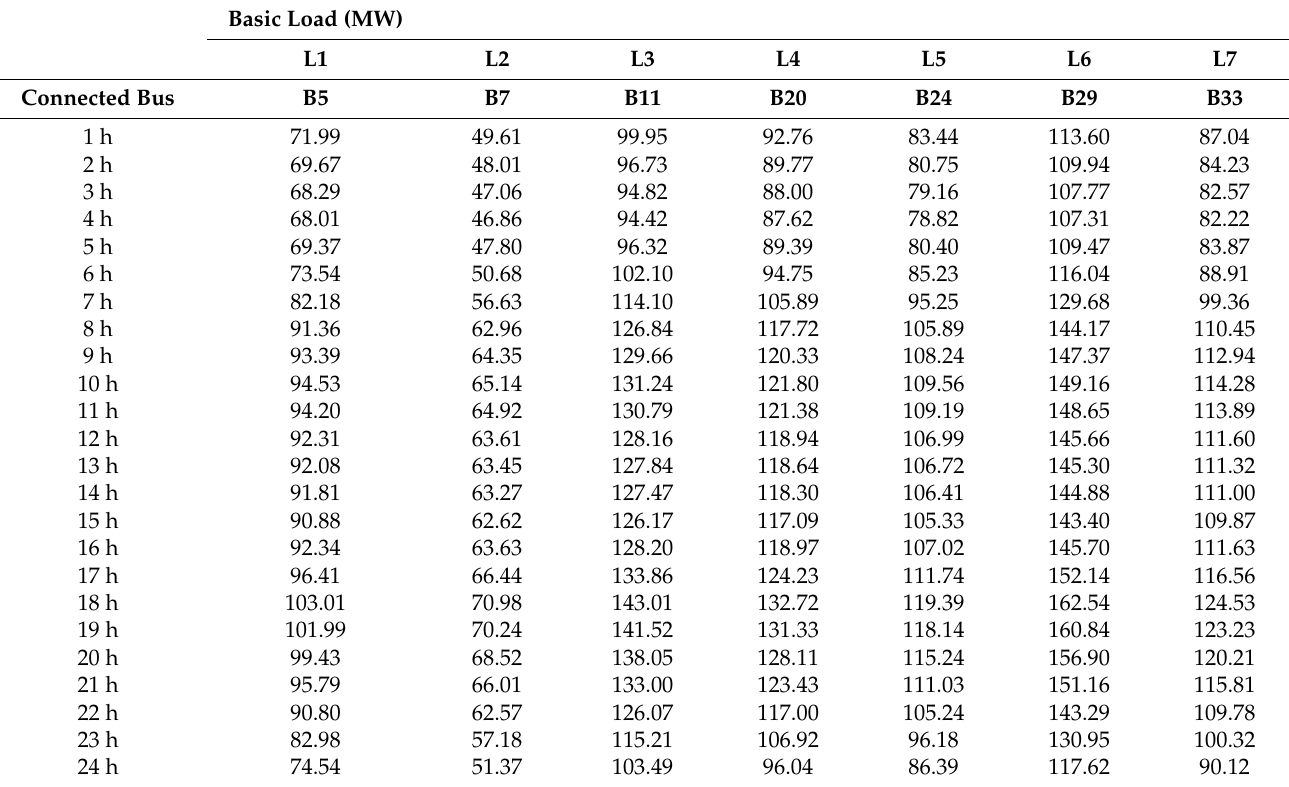
Table A4. Data of the base load in the 33-bus system.